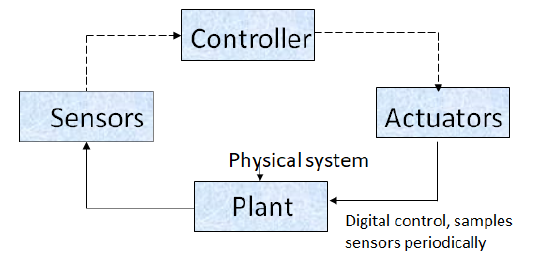
Figure 7. Industrial control